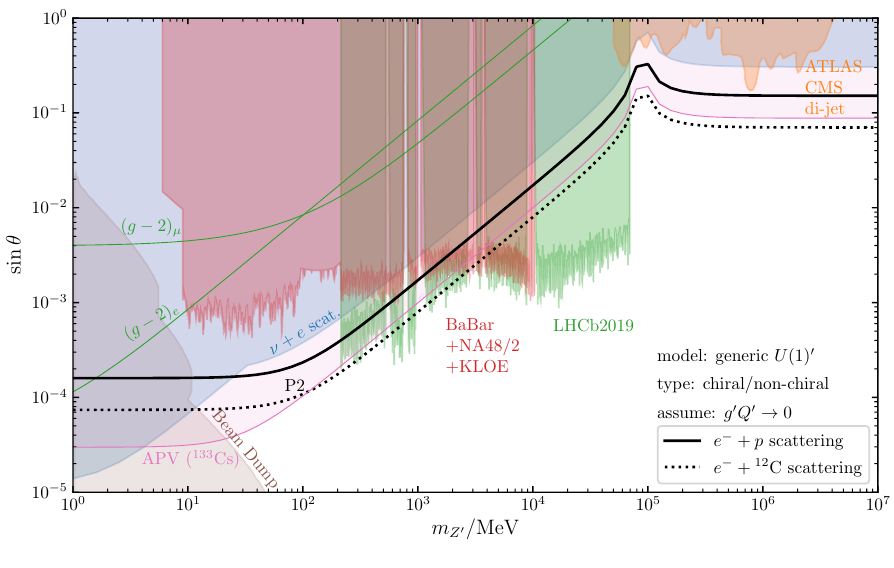
Figure 3 . Sensitivity of the P2 experiment to the generic U(1) 0 model with only mass mixing sin θ and in the limit of g 0 Q 0 = 0 . The notation is the same as in figure 2.